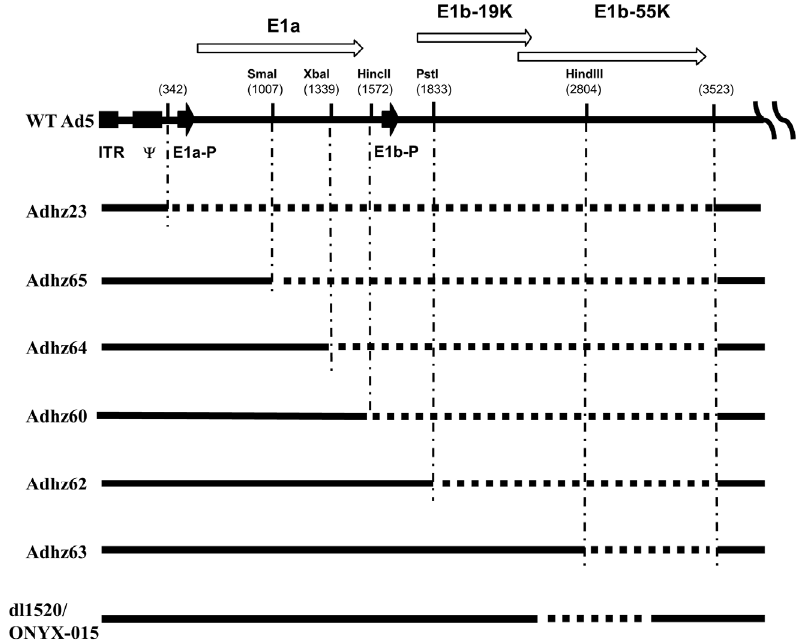
Figure 1. Depiction of the human Ad5 left end with various deletions in E1 genes. All the nucleotide coordinates refer to Ad5 (Genbank Accession No M73260). The wild-type Ad5 with the E1a and E1b genes and their endogenous promoters is shown at the top. The left inverted terminal repeat (ITR), packaging signal ( Ψ ), the E1a and E1b promoters (E1a-P and E1b-P), and the open reading frames are indicated. E1B19K and E1B55K have a small overlap. The solid lines represent Ad regions in these viruses, and the dashed lines represent the deleted regions. The restriction enzyme and the cleaving sites used to delete the E1 region are shown. Ad dl1520 carries native E1A promoter (E1A-P) to drive E1A expression and an 827-bp deletion with a point mutation to generate a premature stop codon in the E1B55K coding region.